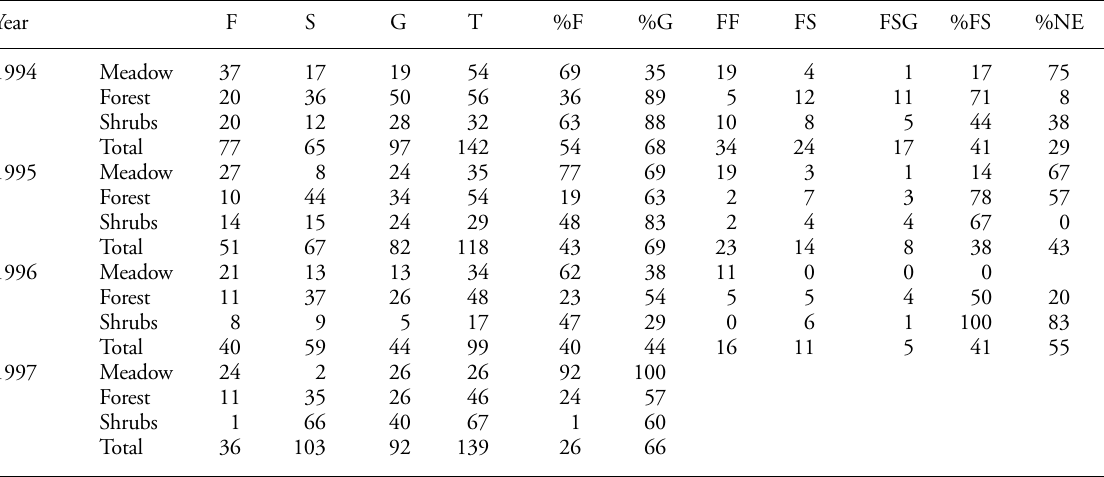
Table 2. Number of flowering plants (F), of sterile plants (S) and their total (T = F+S), number of grazed plants (G), percentage of flowering and grazed plants, (%F) and (%G), respectively, number of transitions flowering in two consecutive years (FF) and flowering one year – sterile the next year (FS), number of FS plants which were grazed (FSG), percentage of the FS plants out of all plants which flowered the previous year %FS = 100*FS/(FF+FS) and percentage of FSG plants in all FS plants (“not explained” – %NE = 100*(1- FSG/FS)). Data on Dactylorhiza fuchsii from